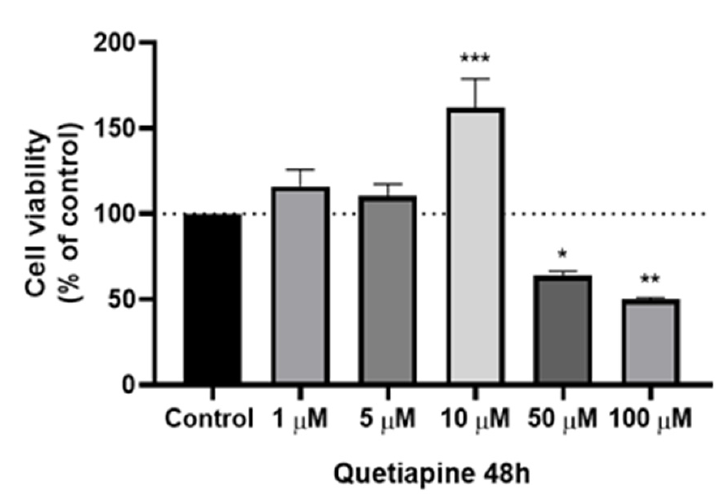
Figure 8. Effect of quetiapine exposure over 48 h on the cell viability (% of control) of MCF-7 cells, based on four independent experiments (n = 4). Results are expressed as mean ± standard error of the mean (SEM). * p < 0.05, ** p < 0.01 and *** p < 0.001. At a 10 µ M concentration, cell viability increased compared to the control, possibly due to drug interactions with the MTT. A dose-response curve was calculated, and the IC50 value for quetiapine was determined at 46.63 µ M (Figure 9). However, the IC50 values found were deemed too high for our purposes, and this drug was ruled out of further research.